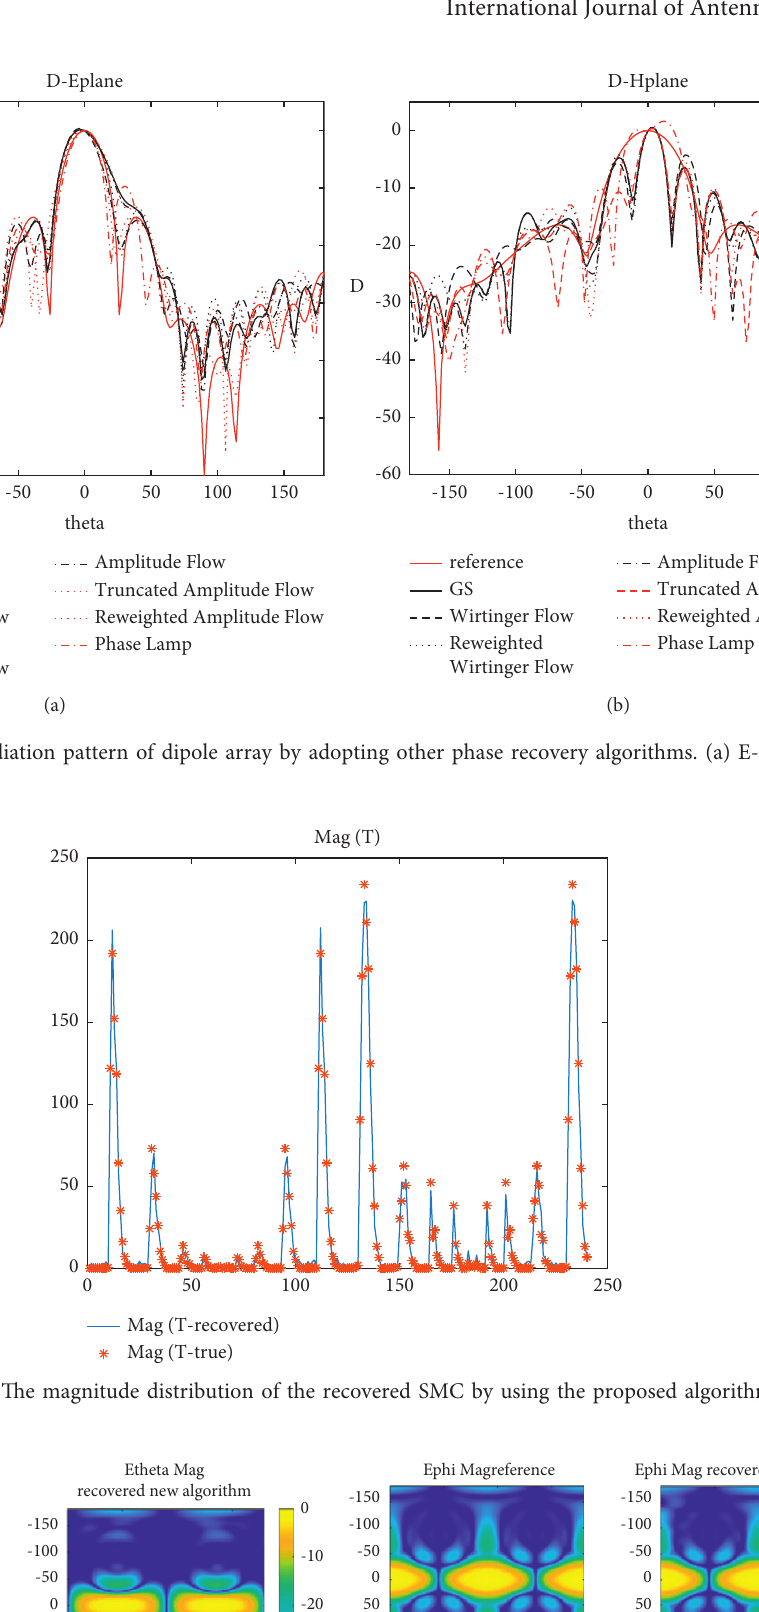
and E of dipole array by adopting the proposed algorithm. (a) E θ φ